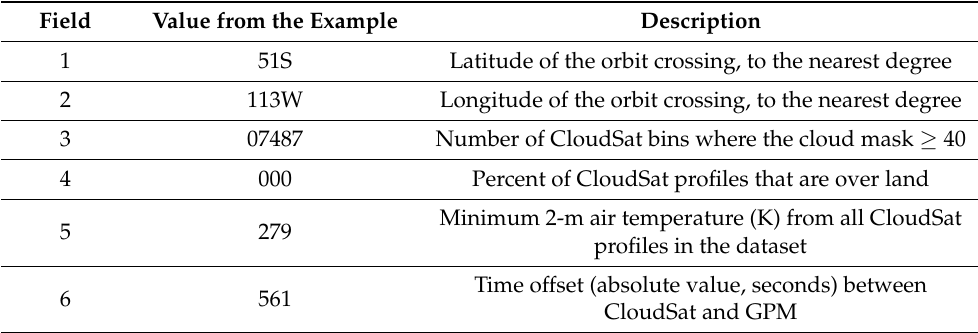
Table A2. Descriptions for the fields within a CloudSat-GPM coincidence file